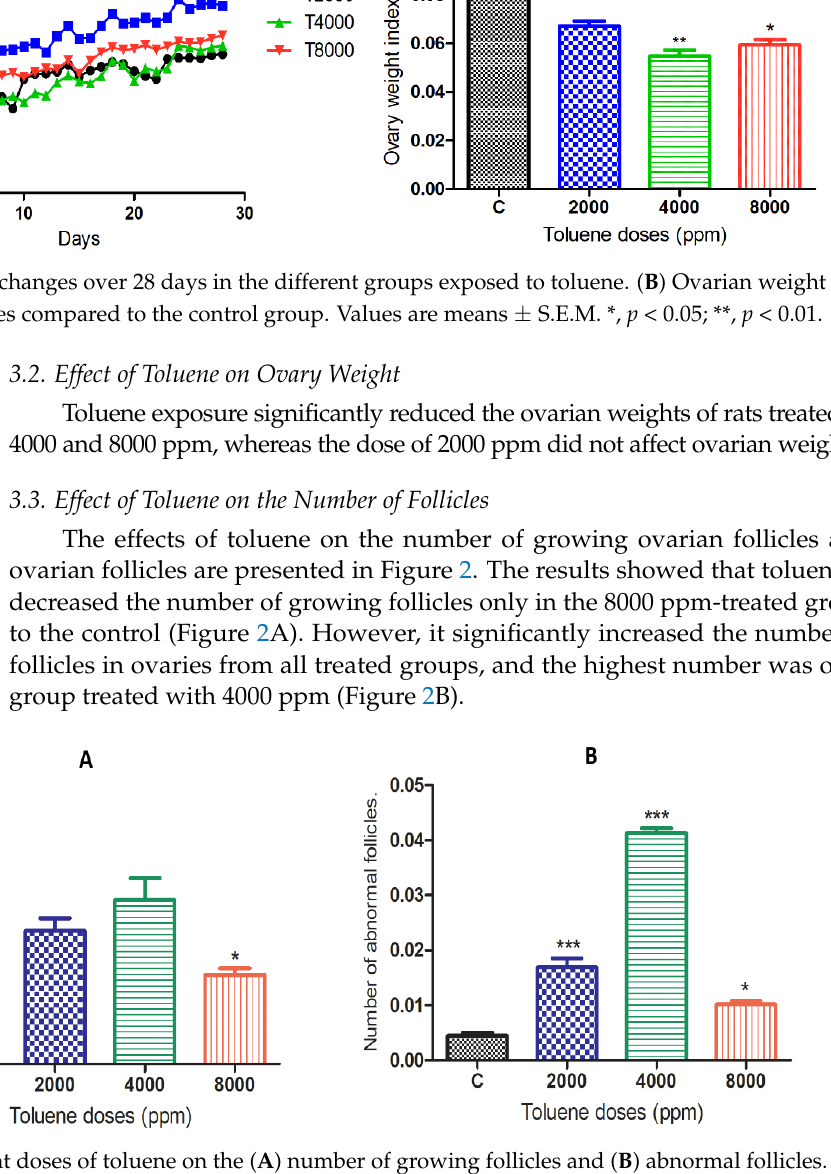
Figure 2. Effects of different doses of toluene on the ( A ) number of growing follicles and ( B ) abnormal follicles. Values are means ± S.E.M. *, p < 0.05; ***, p < 0.001.